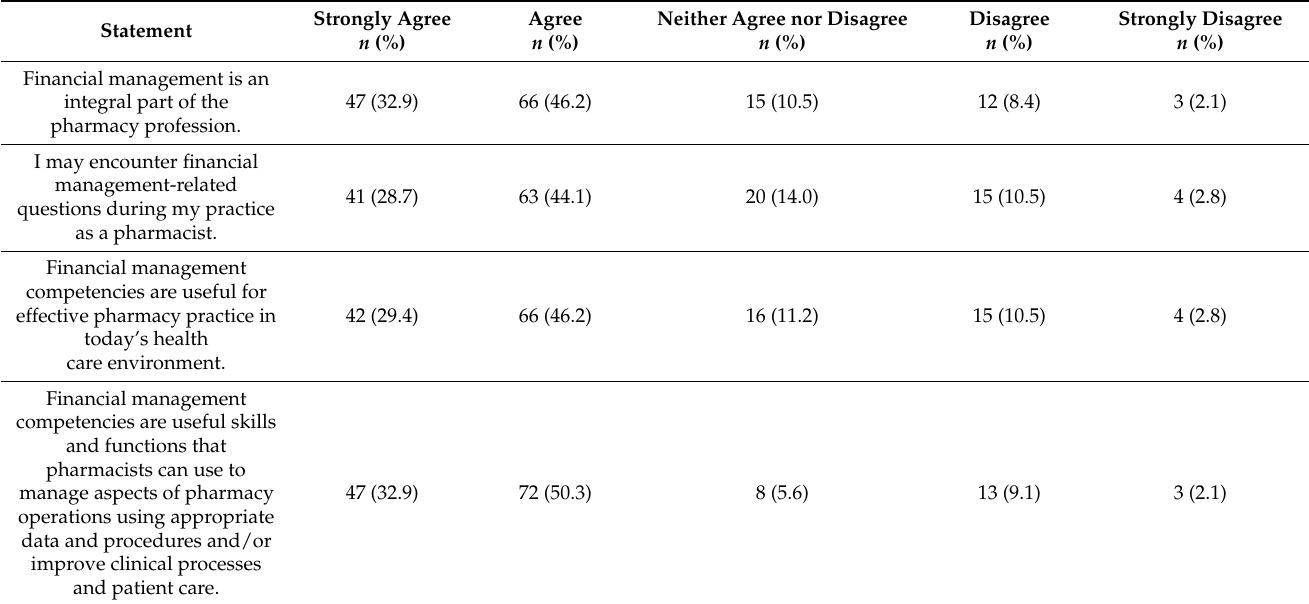
Table 3. Perception of the clinical relevance of pharmacy financial management education ( n =